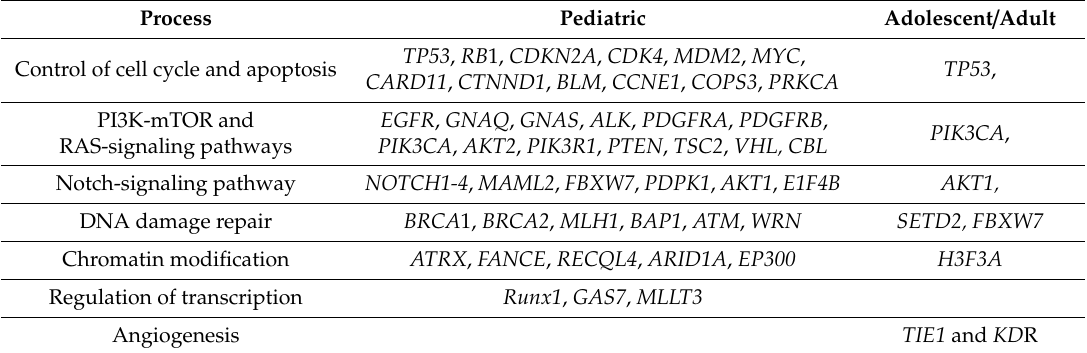
Table 2. Comparison of altered genes in pediatric and adolescent / adult patients in osteosarcoma based on